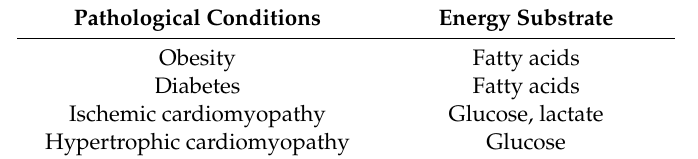
Table 1. Energy substrates preferences of myocardium on pathological conditions.